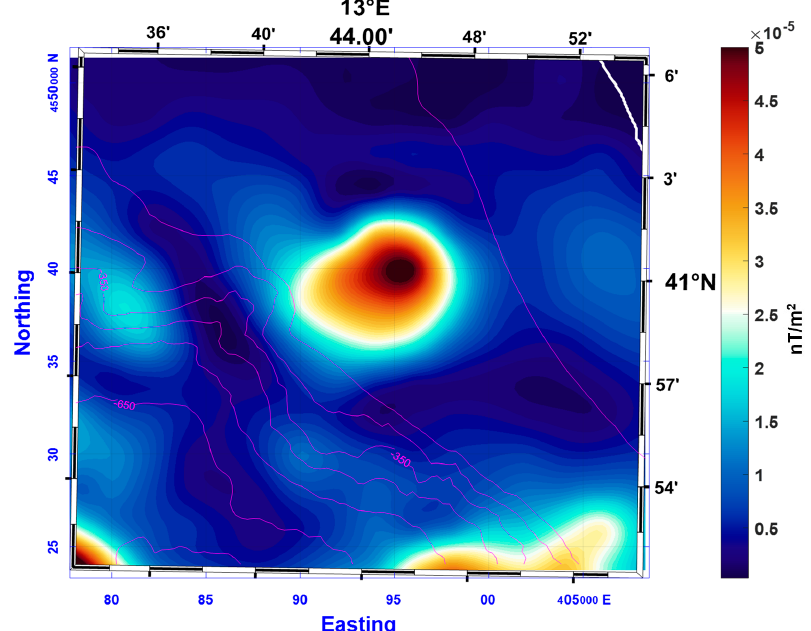
Figure 10. Total field aeromagnetic anomalies of the Gaeta Gulf continued downward to sea level. Letters identify magnetic anomalies described in the text. The black line in the northeast corner of the map represents the coastline.